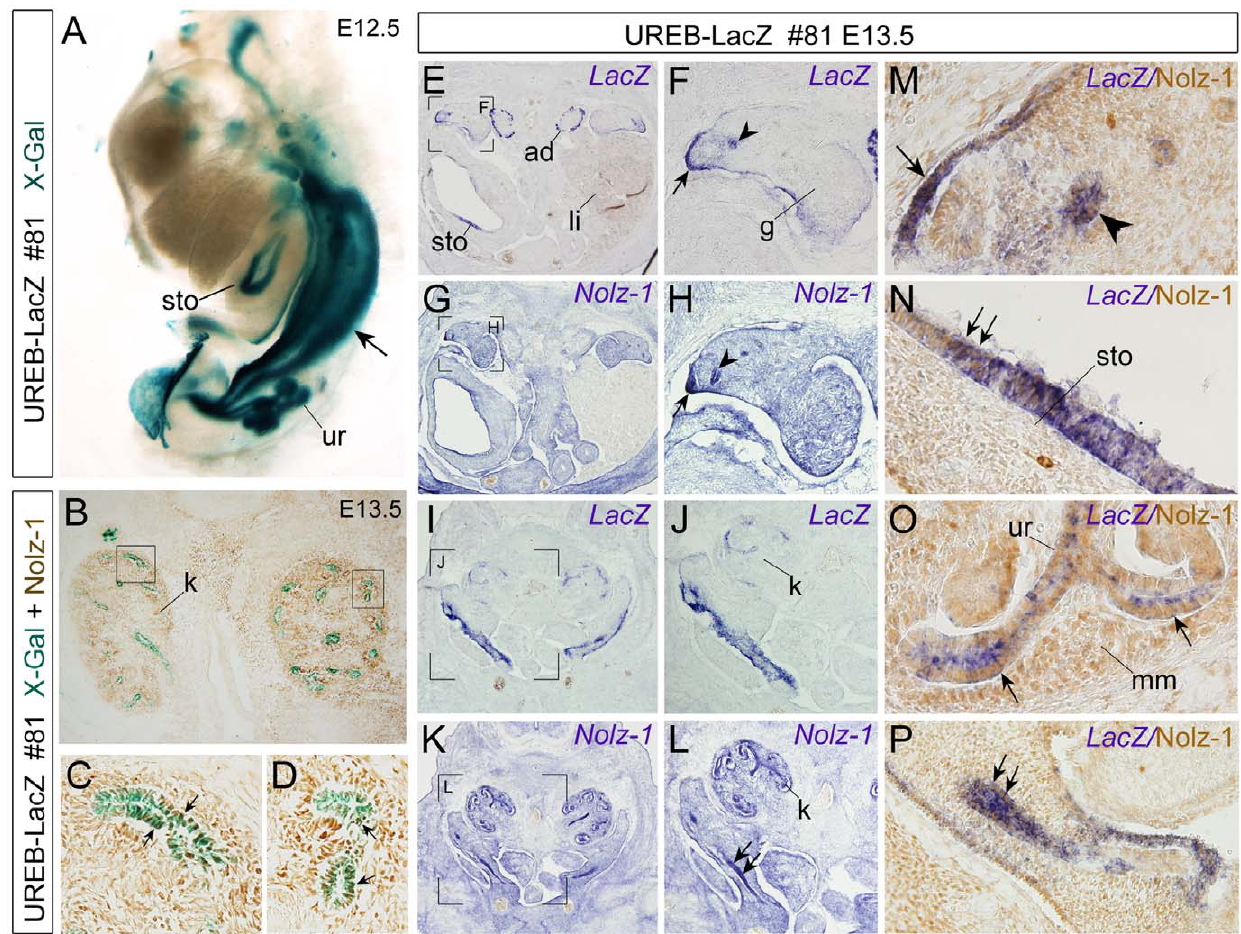
Figure 8. Detection of X-gal-positive signals in Nolz-1-expressing urogenital organs of UREB-LacZ embryos. A: By whole-mount staining, X-gal-positive signals are detected in the urogenital duct (arrow), ureteric tubules (ur) and stomach (sto) of E12.5 line # 81 embryos. B–C: Many X-gal + /Nolz-1 + cells (arrows in C, D) were detected in some renal tubules of E13.5 kidney (k). The boxed regions in B are shown at high magnification in C, D. E –L: Expressions of LacZ (E, F, I, J) and Nolz-1 mRNAs (G, H, K, L) in transverse sections of urogenital organs of E13.5 line # 81 embryos. The bracketed regions in E, G, I, K are shown at high magnification in F, H, J, L, respectively. M–P: Double labeling of LacZ mRNA (purple) and Nolz-1 protein (brown). LacZ and Nolz-1 mRNAs are both detected in the genital ridge (arrow) and genital duct (arrowhead) (see also arrow and arrowhead in F, H). Many LacZ + /Nolz-1 + cells are detected in these genital tissues (M). LacZ mRNA is also detected in the adrenal gland (ad, E) and stomach (sto, E) of UREB-LacZ embryo. LacZ and Nolz-1 co-expressing cells in stomach are detected (arrows, N). In the embryonic kidney (k), LacZ mRNA is mainly expressed in tubular cells (I, J, O), whereas Nolz-1 mRNA (K, L) and protein are detected broadly both in the metanephric mesenchyme (mm, O) and in ureteric tubules (ur, O). LacZ and Nolz-1 co-expressing cells in ureteric tub are detected (arrows, O). Double arrows in L and P indicate Nolz-1 expression in urogenital tube where LacZ and Nolz-1 co-expressing cells are found. g, gonads; li, liver; ad, adrenal gland.